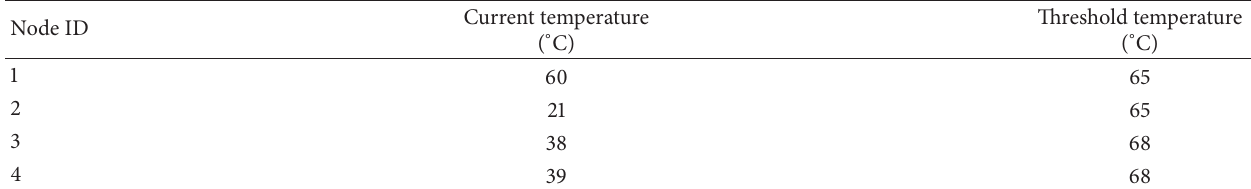
Table 14: Unified list (S2).